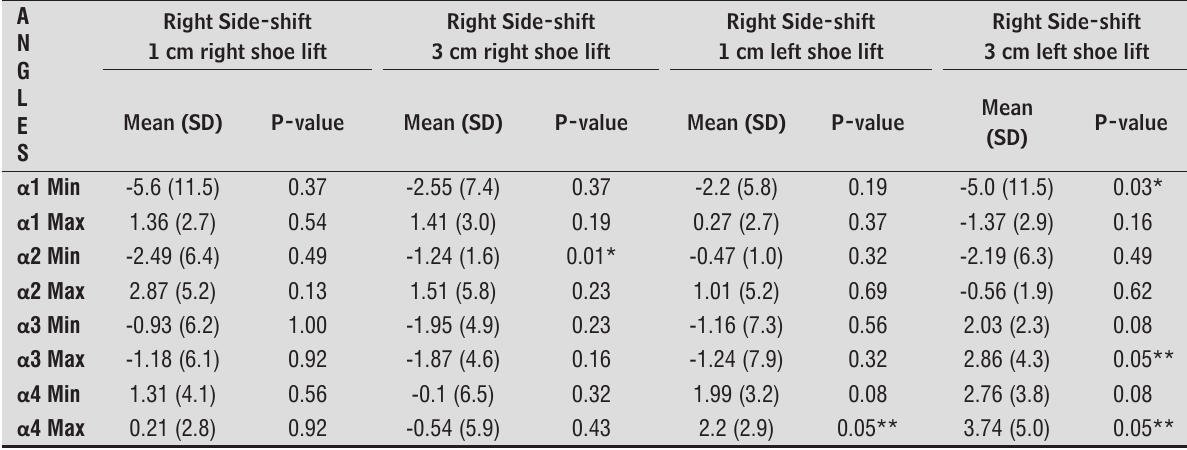
Table 2 - Difference between means (maximum and minimum) of α 1, α 2, α 3 and α 4 in side-shift movements to the right with shoe lifts of 1 cm and 3 cm in relation to the static position and p value